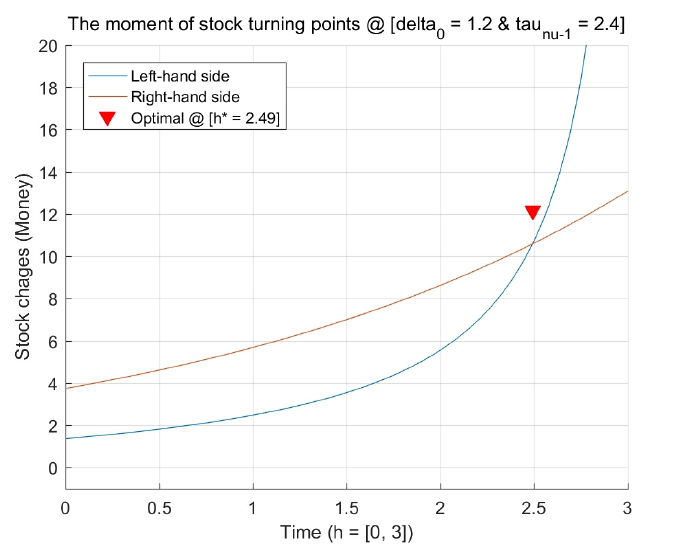
Figure 3. Find the optimal moment h ∗ using